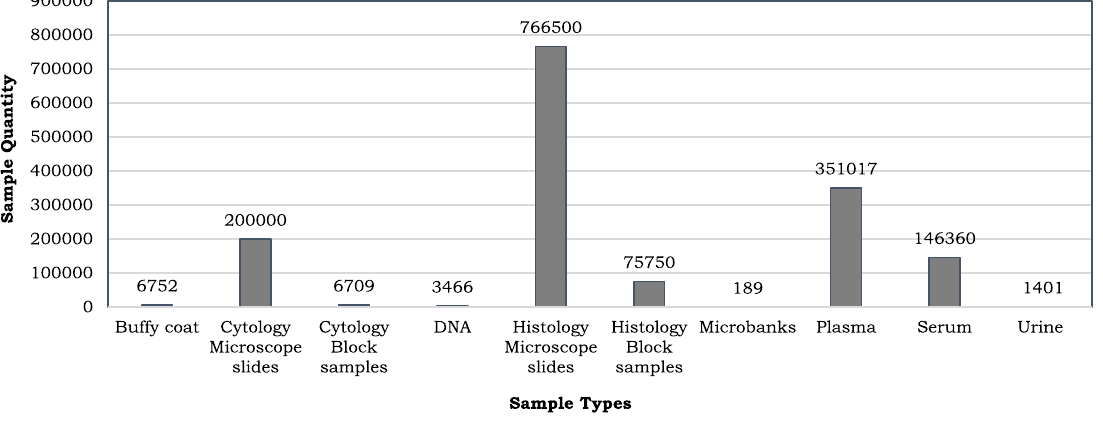
Figure 1: Sample types and quantities in storage at the NHLS Biobank.